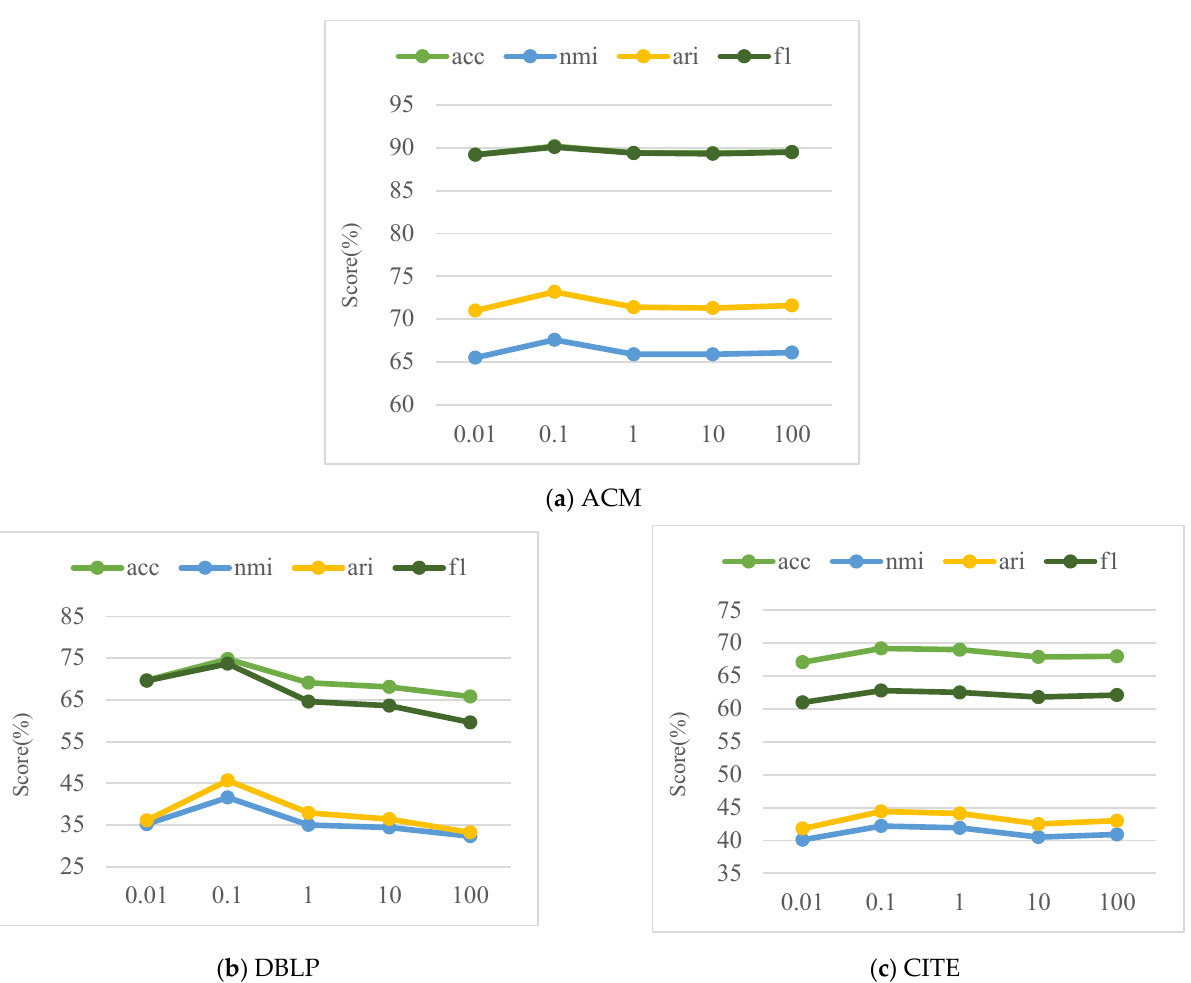
Figure 3. The influence of parameter 𝛼 on the model effect.